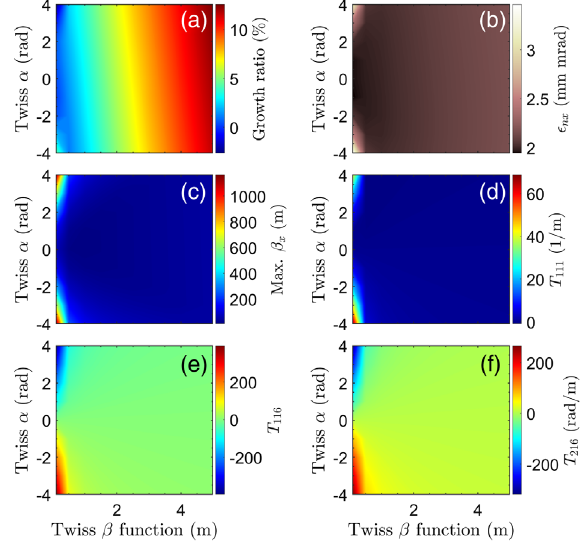
FIG. 6. (a) Relative change of the emittance with higher-order terms considered, (b) final normalized emittance from the achromatic dog-leg transfer line, and (c) maximum Twiss β function along the transfer line. Also shown are the second-order transfer map components (d) T 111 , (e) T 116 , and (f) T 216 , with the initial Twiss β function ranging from 0.1 m to 5.0 m and Twiss α function ranging from − 4 . 0 to þ 4 . 0 . All the results in this figure were obtained by ELEGANT simulations.